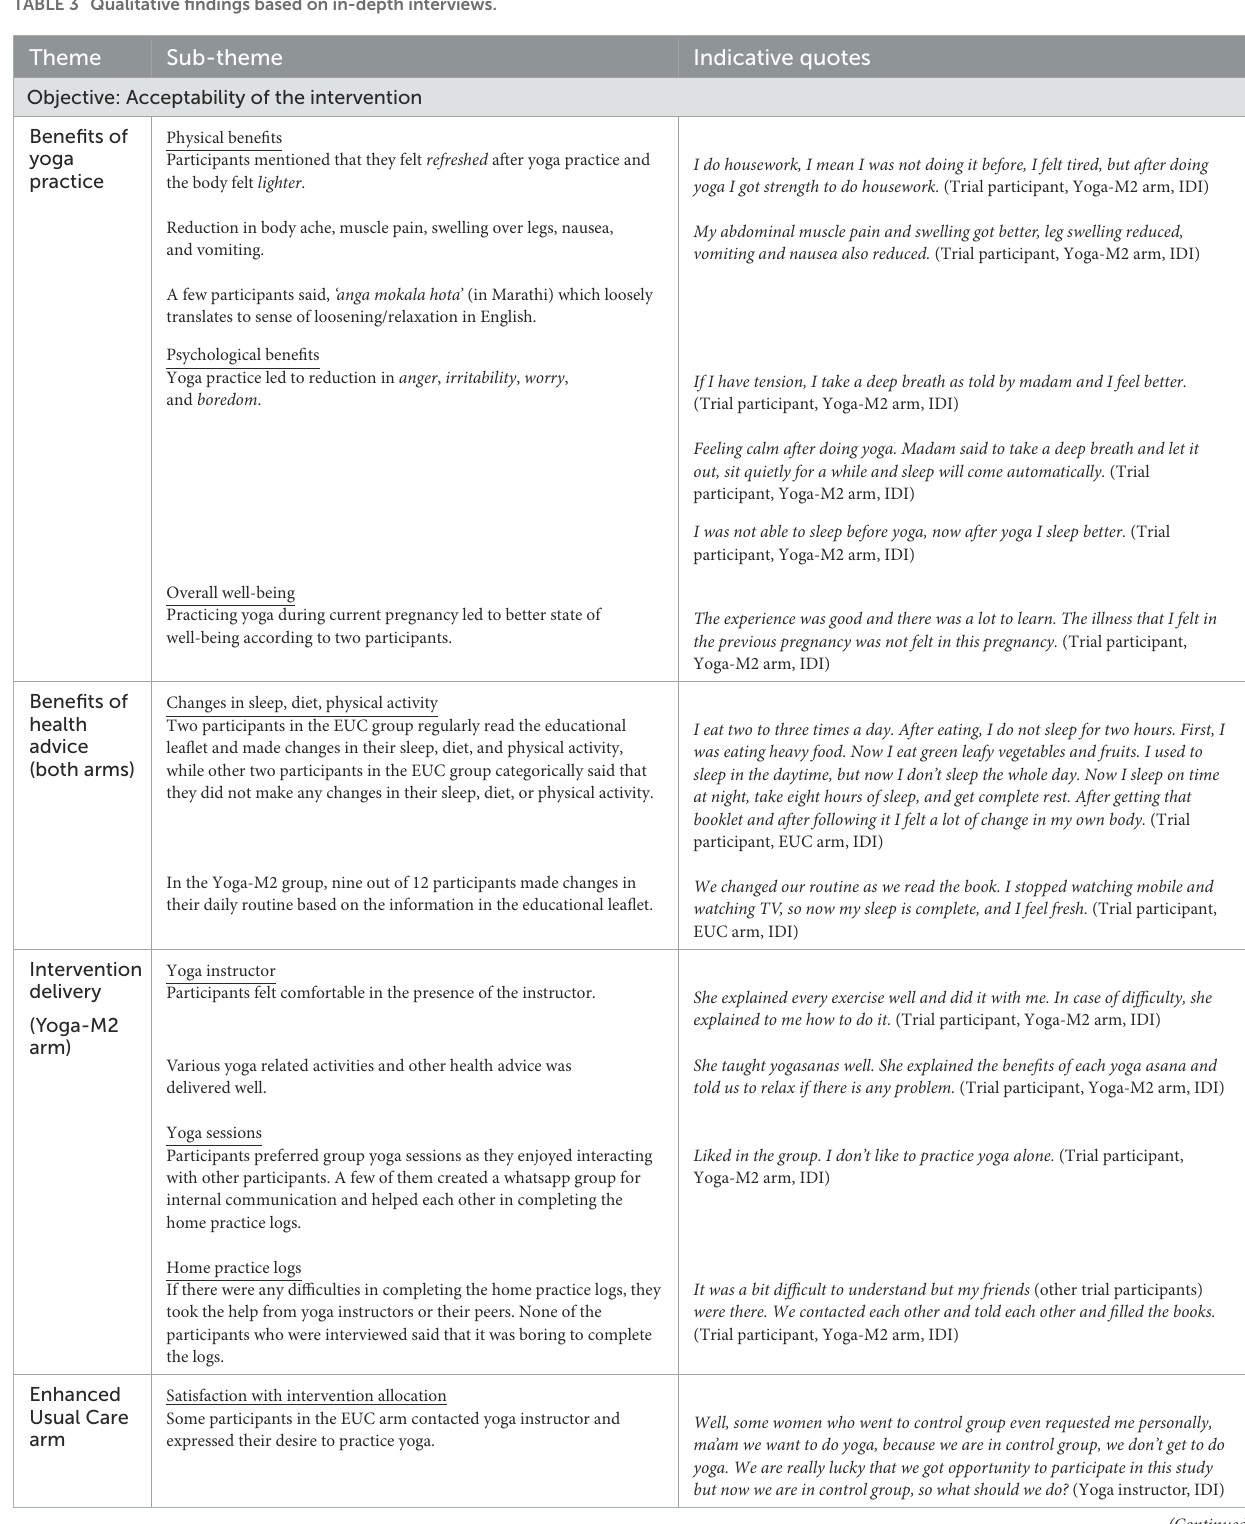
TABLE 3 Qualitative findings based on in-depth